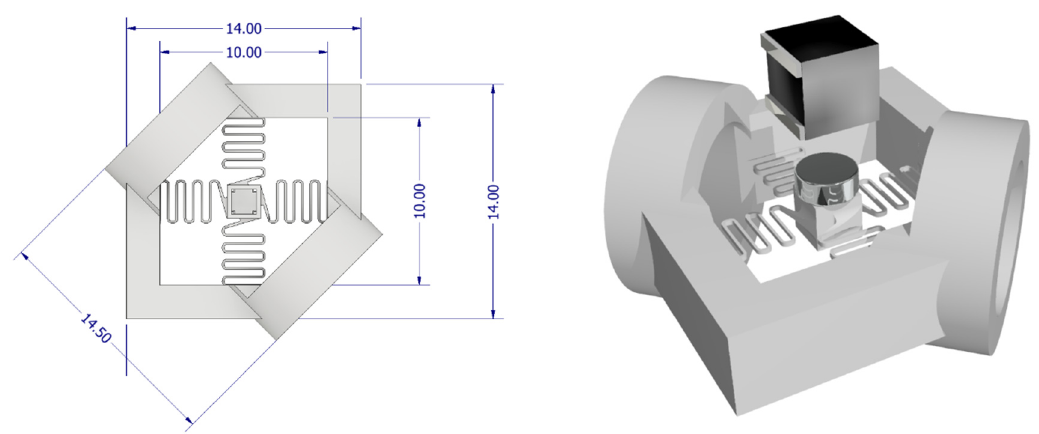
Figure 1. ( left ) Visualization of the 3D-printed energy harvester with main dimensions in mm and ( right ) with assembled magnet coupled with one miniature coil.